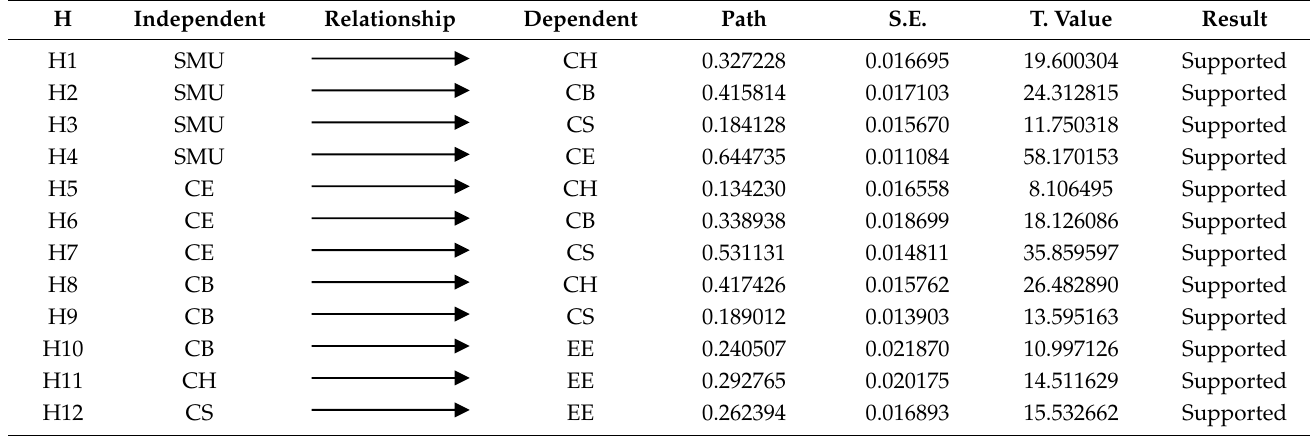
Table 4. Hypothesis testing results of structural model.